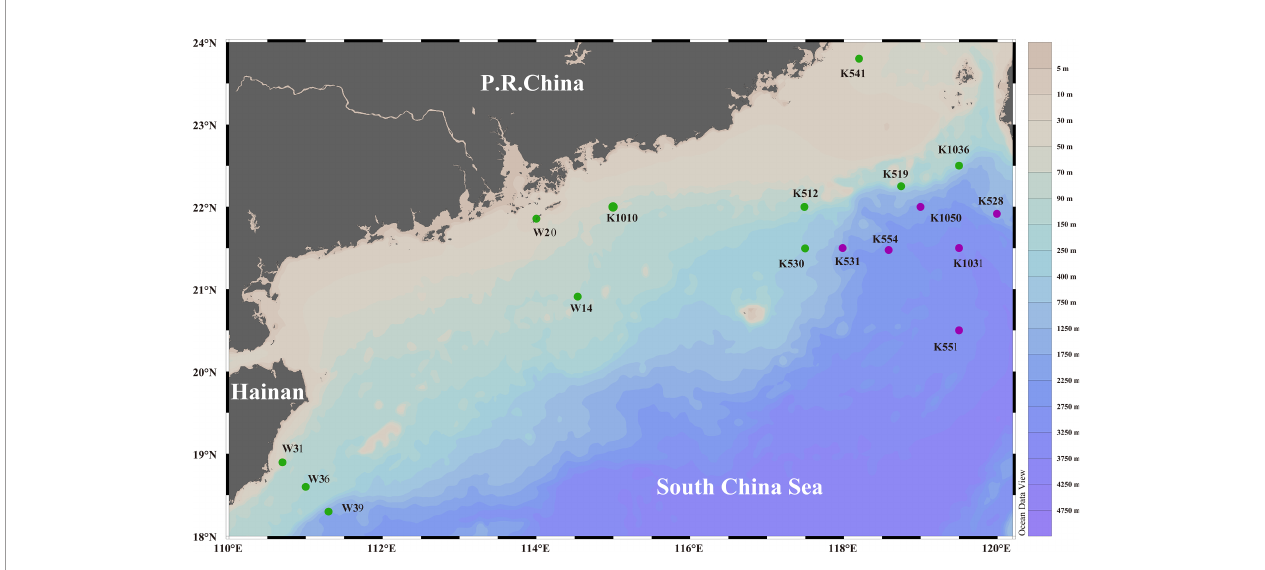
FIGURE 1 | The map of sampling sites. The dots denoted sampling stations (green dots represent shallow-sea stations and purple dots represent deep-sea stations), and the scale bar denoted water